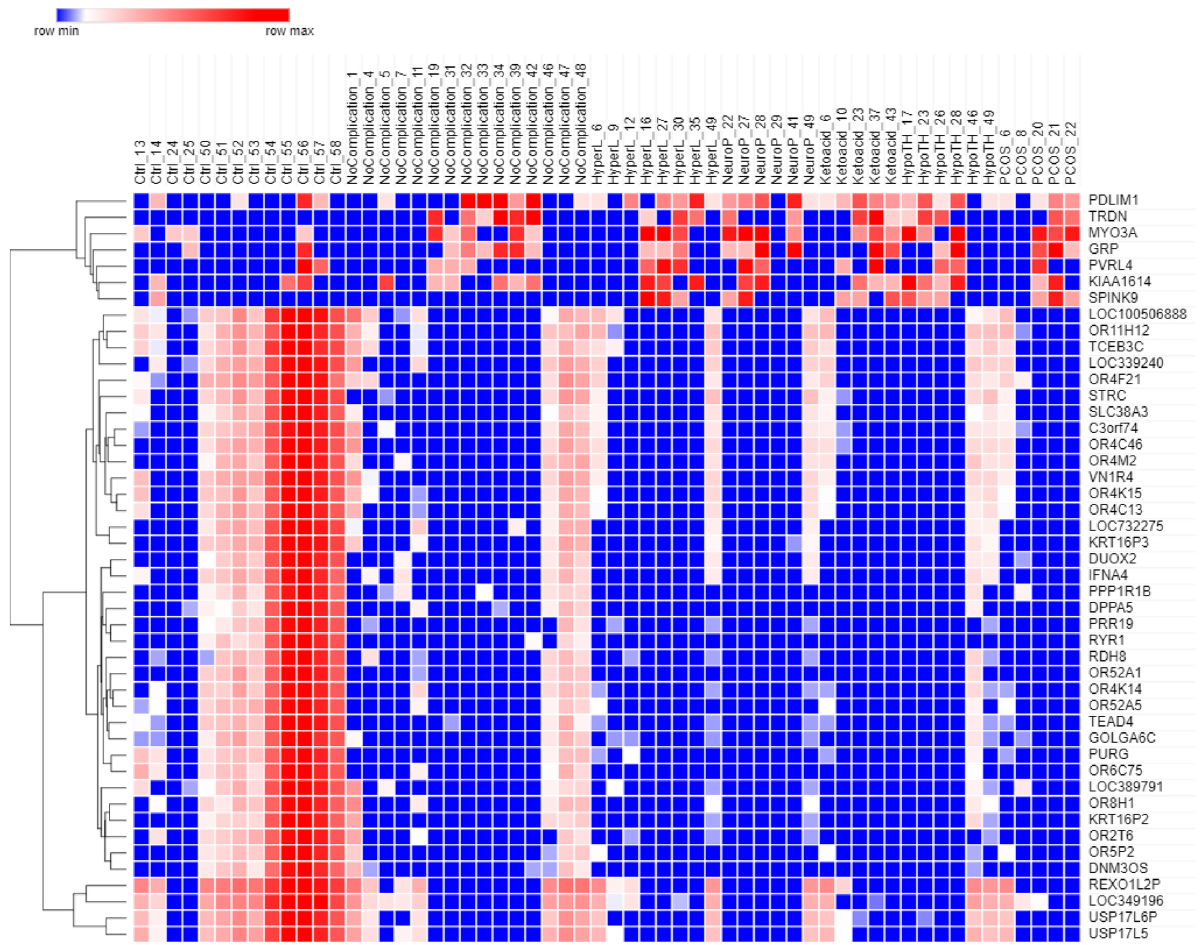
Figure 1. Heat map of overlapping differentially expressed genes as identified by ANOVA and eBayes analysis of healthy controls, T1DM with no complications and T1DM with complication groups. Red color represents upregulated genes whereas blue color represents downregulated genes. Color scale is shown on the top left corner of the figure. Ctrl control, HyperL Hyperlipidemia, NeuroP Neuropathy, Ketoacid Ketoacidosis, HypoTH Hypothyroidism, PCOS Polycystic Ovarian Syndrome.